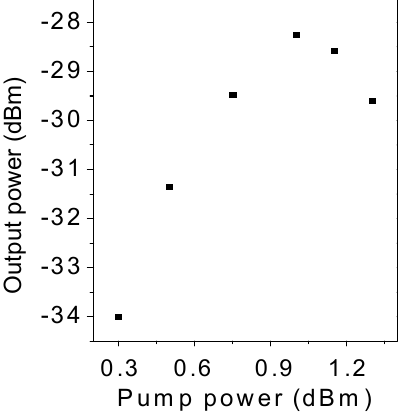
Figure 6. Evolution of laser power vs. Raman pump